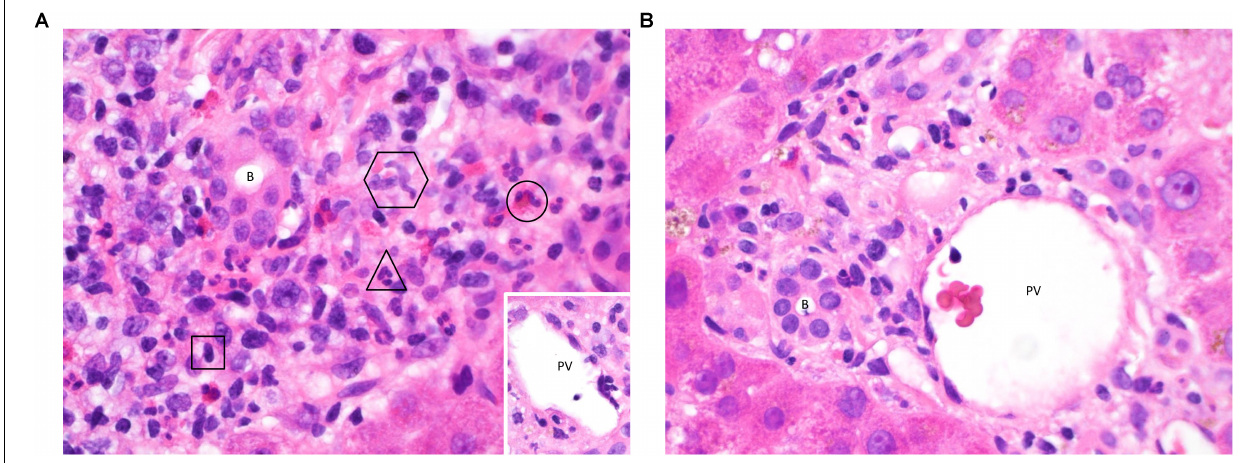
FIGURE 1 | (A) Acute TCMR 6 days post liver transplant. This high-power image (hematoxylin & eosin (H&E), × 600) of a portal tract shows infiltration of a large number of inflammatory cells. Typical examples of a lymphocyte (square), neutrophil (triangle), eosinophil (circle) and two macrophages (hexagon) are highlighted, demonstrating the contribution of cells from both the innate and adaptive immune systems. The majority of the lymphocytes will be T-cells, capable of mediating cell damage through direct cytotoxicity and the release of pro-inflammatory cytokines. There is clustering around the bile duct (B) and portal vein (PV, inset, with damage to endothelium seen at 4 o’clock). Neutrophils and macrophages migrate to the liver in response to pro-inflammatory cytokines, enhanced by Th1 and Th17 responses. Eosinophils are also present in early rejection infiltrates and are more typically associated with a Th2 response. Treatment with high dose pulsed methylprednisolone was able to suppress the rejection episode in this patient and tolerance has since been maintained using a standard immunosuppressive regimen. (B) Immune tolerance 8 days post liver transplant. In contrast to Figure 2A , a portal tract from this biopsy (H&E, × 600) contains only a small number of lymphocytes, macrophages and neutrophils with no evidence of damage to biliary epithelium (B) or portal vein endothelium (PV). Tolerance to the liver allograft is promoted by multiple factors including the relatively low levels of MHC class II expression on hepatic-resident cells, a tendency toward tolerogenic antigen presentation by the dendritic cells, macrophages, stellate cells and epithelial cells resident in the liver, the dominance of a regulatory T-cell infiltrate and the action of donor-derived NK cells on the recipient immune system. Indeed, a biliary complication of surgery was found to be the reason for liver dysfunction in this patient, and tolerance was maintained on follow-up by means of a standard immunosuppressive regimen without the need for additional